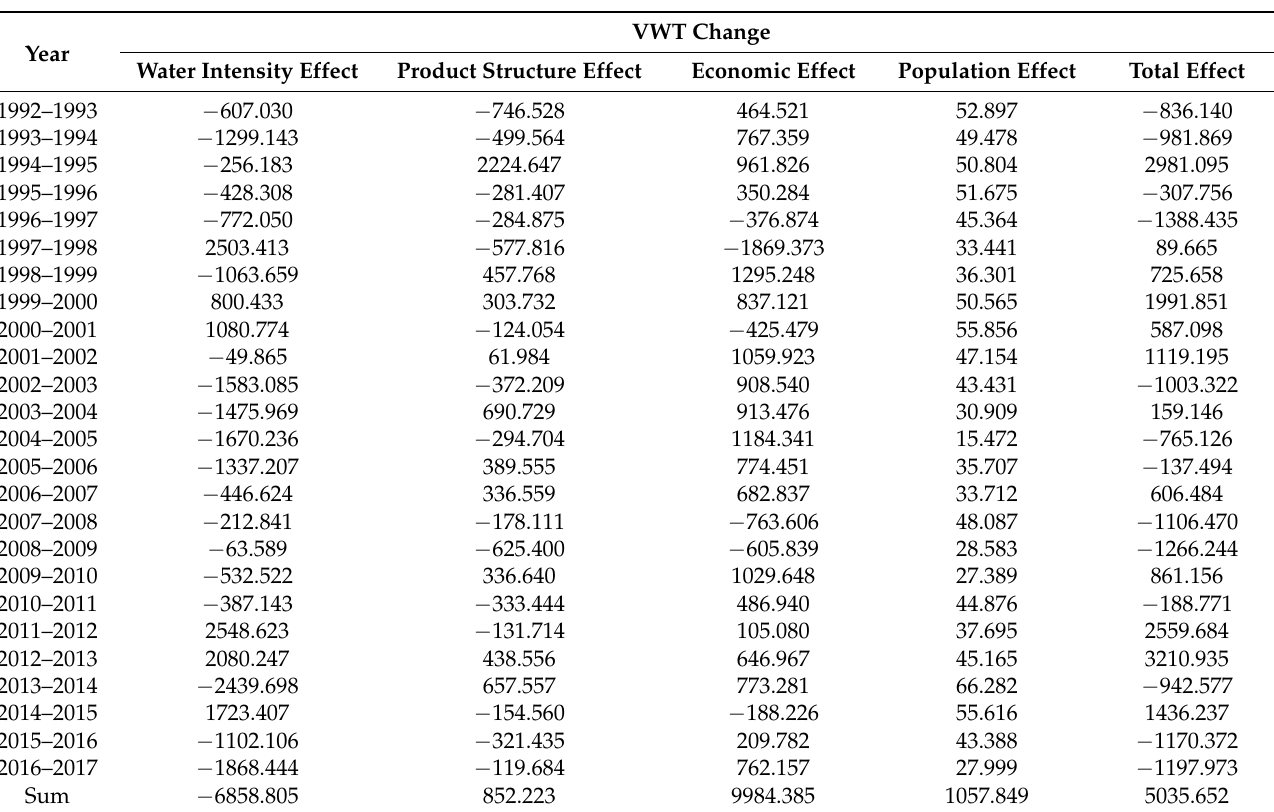
Table A3. The logarithmic mean divisia index (LMDI) analysis of maize virtual water trade (VWT) change in South Korea (million m 3 ).